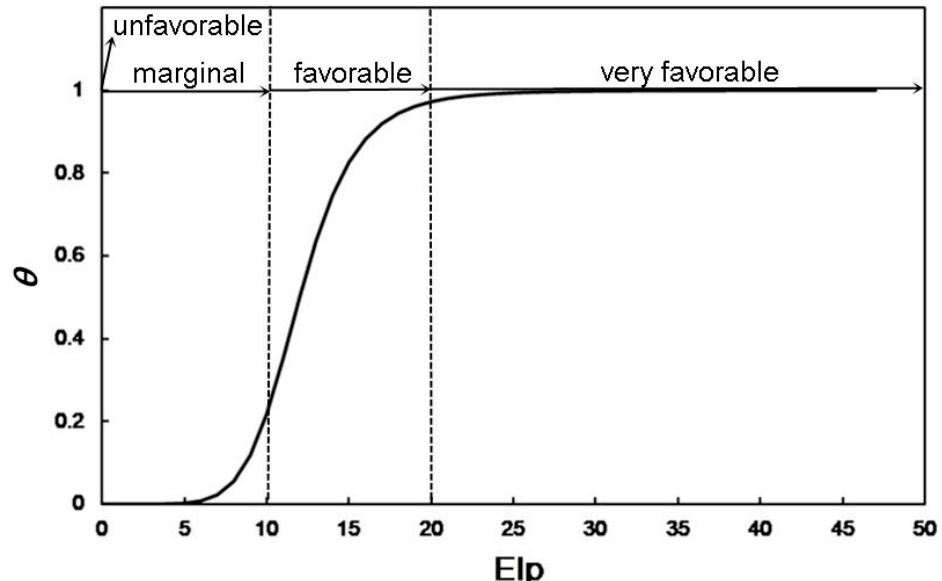
Figure 2. The sigmoidal curve of ecoclimatic index (EI) values of host plants ( Pinus spp.) used to simulate host plant availability ( θ ). A value of 0 for θ indicates an area unfavorable for host plant growth ( EI P = 0); a low θ value indicates a region providing marginal support for host plant growth ( EI P ≤ 10); a high value of θ indicates an area favorable or very favorable for host plant growth ( EI P > 10).